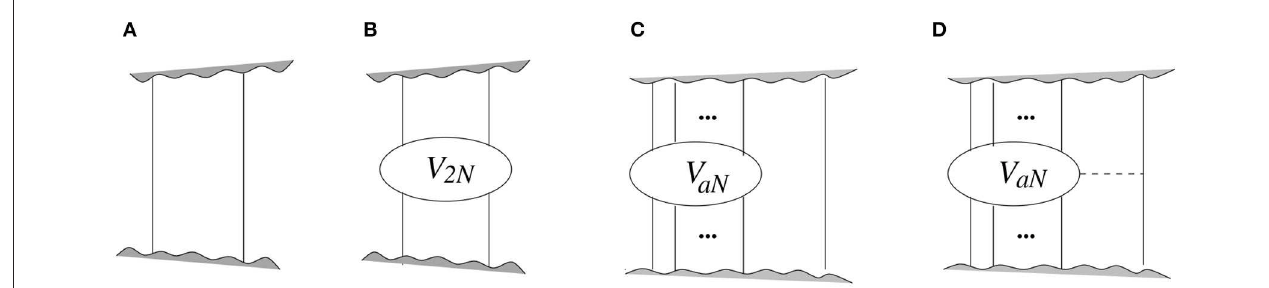
FIGURE 1 | Some diagrams discussed in the text. Inside a diagram, (A) two nucleons (solid lines) propagate; (B) two nucleons interact through the 2 N potential (blob); (C) a nucleons interact through the aN potential (blob), while another nucleon propagates; and (D) a from the aN potential and the exchange of a pion (dashed